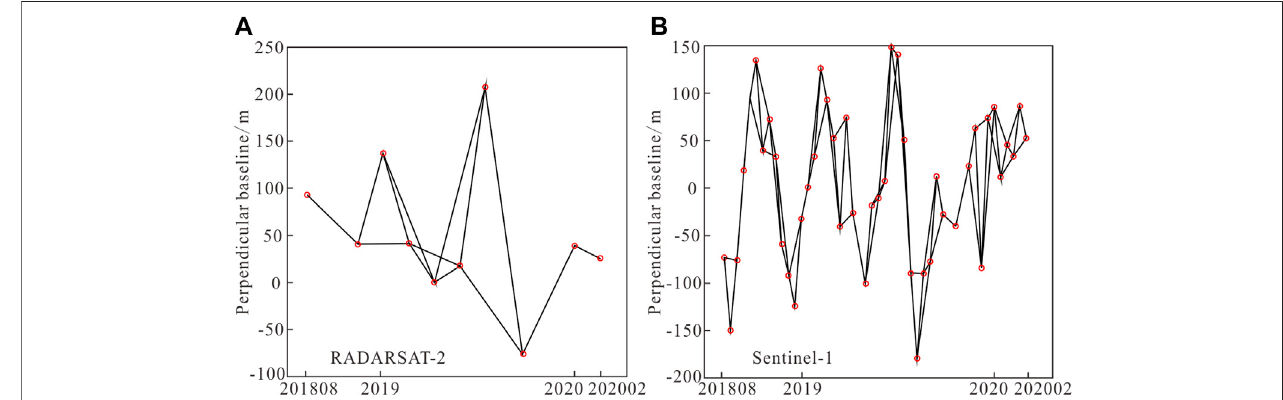
FIGURE 5 | Temporal and spatial baseline of interferometric radar images pairs.